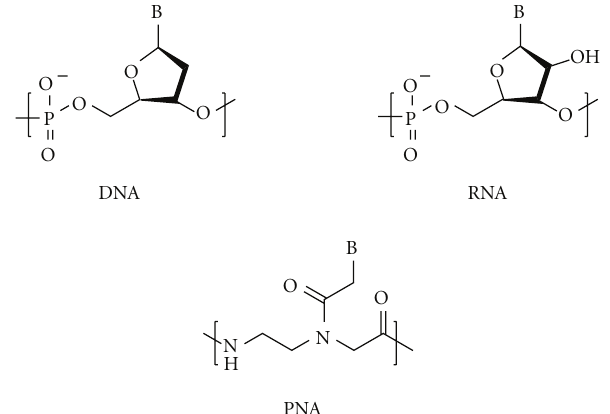
Figure 1: Chemical structure of DNA, RNA, and